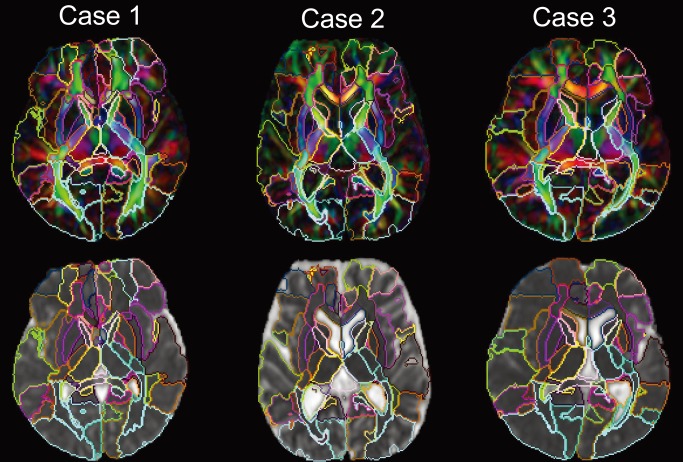
Examples of whole brain parcellations.Results of the whole brain parcellations into 159 structures in three representative cases with large anatomical variability. The parcellation results are superimposed on color (upper row) and MD (bottom row) images.